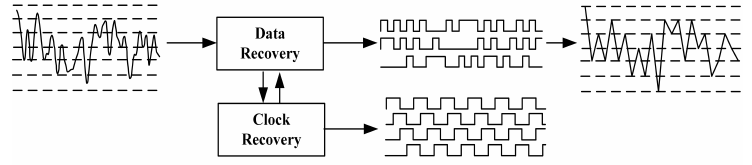
Figure 1. Schematic diagram of DB PAM-4 CDR principle.